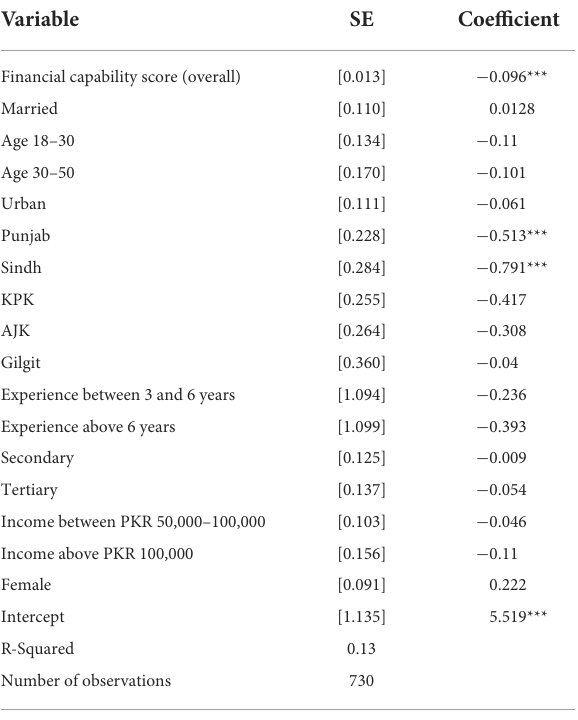
TABLE 5 Effect of overall financial capability on COVID 19 distress.